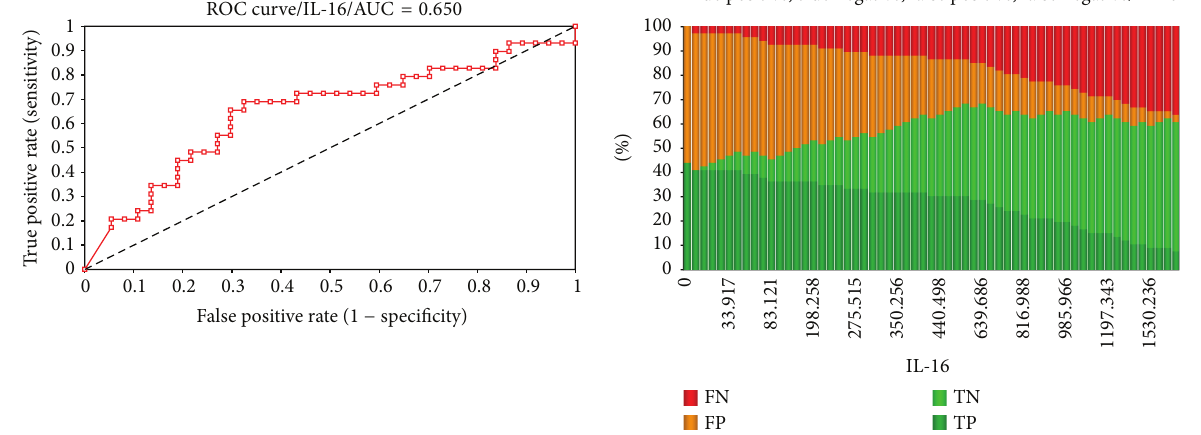
Figure 2: ROC curve and AUC and predictive characteristics of